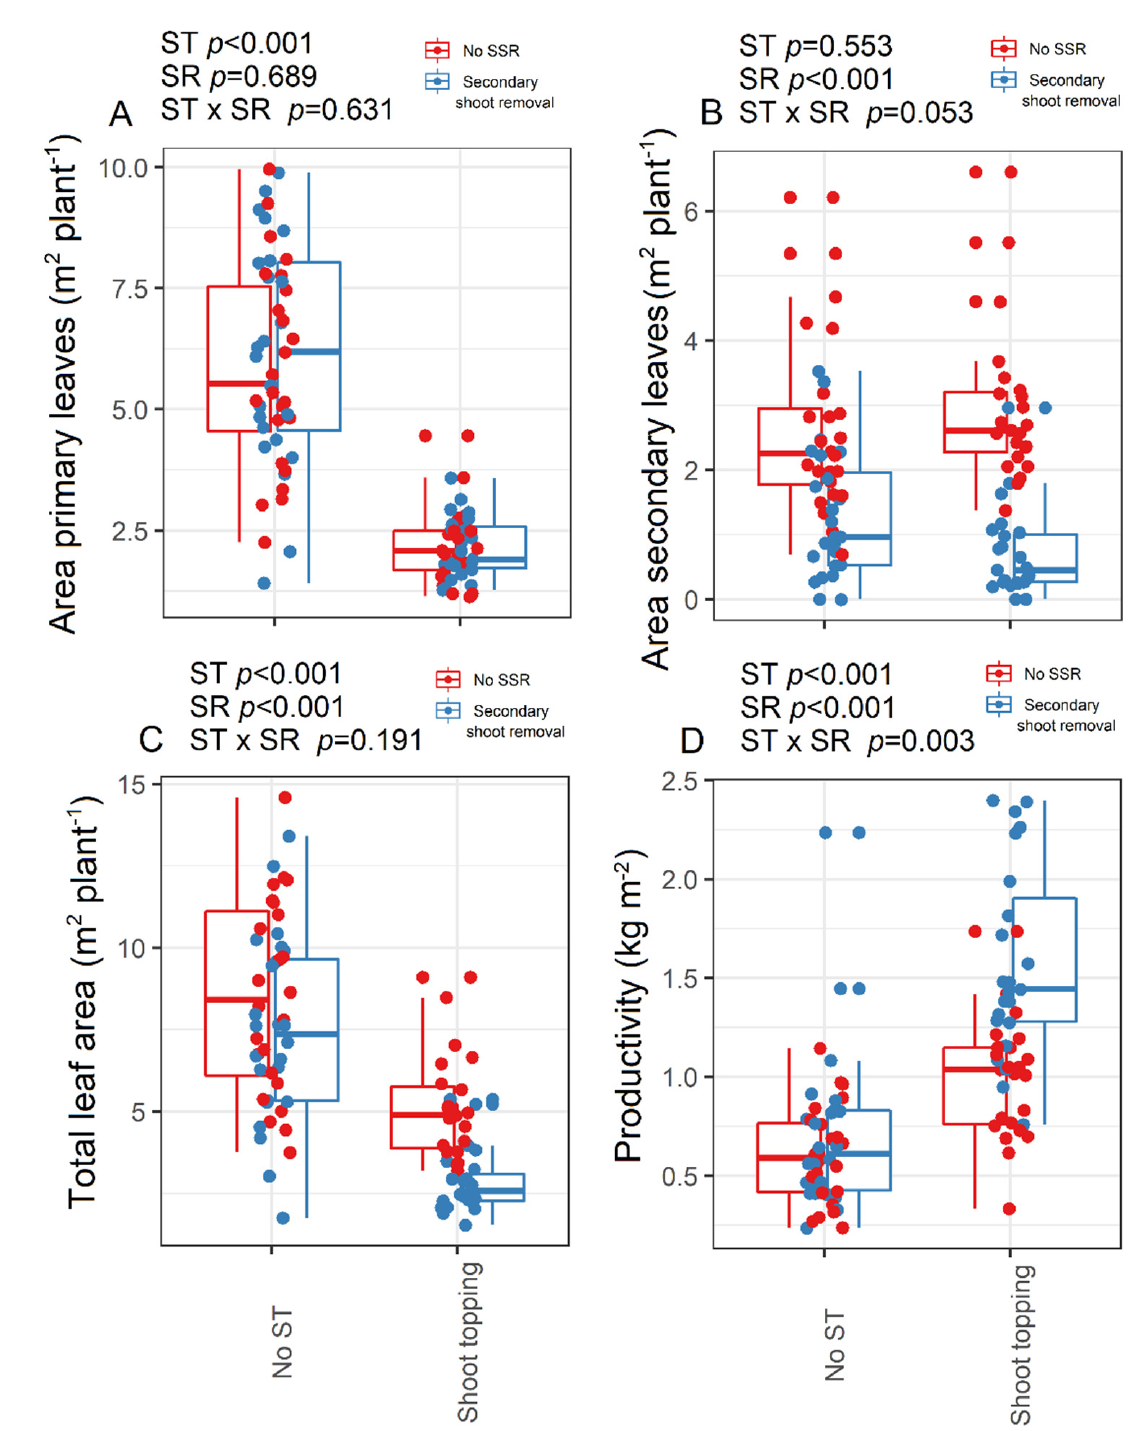
Figure 2. Area of primary leaves ( A ), area of secondary leaves ( B ), total canopy area per plant ( C ), and plant productivity kg/m 2 ( D ) in plants subjected to shoot topping or shoot bundling (no ST) where secondary shoots were either removed (secondary shoot removal) or not (no SSR) (n = 24). In the graphs, points represent raw data, horizontal lines within boxes indicate the median, and boxes indicate the upper (75%) and lower (25%) quartiles. Whiskers indicate the ranges of the minimum and maximum values. Data were analyzed with two-way ANOVA and p -values are shown in the graph (ST—shoot topping factor; SR—secondary removal factor; ST × SR—interaction).